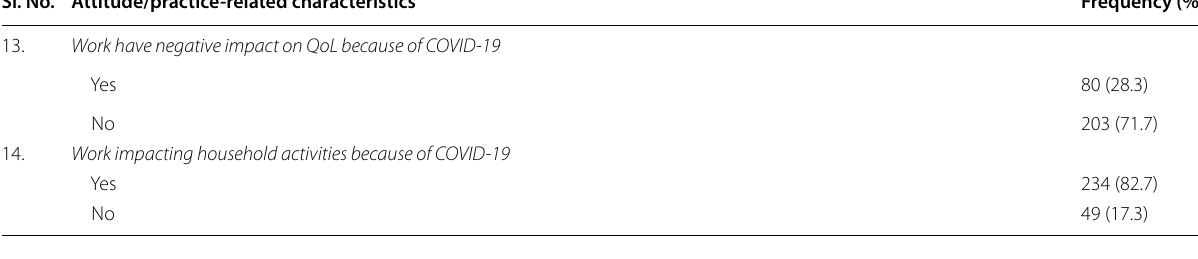
Fig. 1 Prevalence and severity of depression among the healthcare professionals using DASS-21 ( N